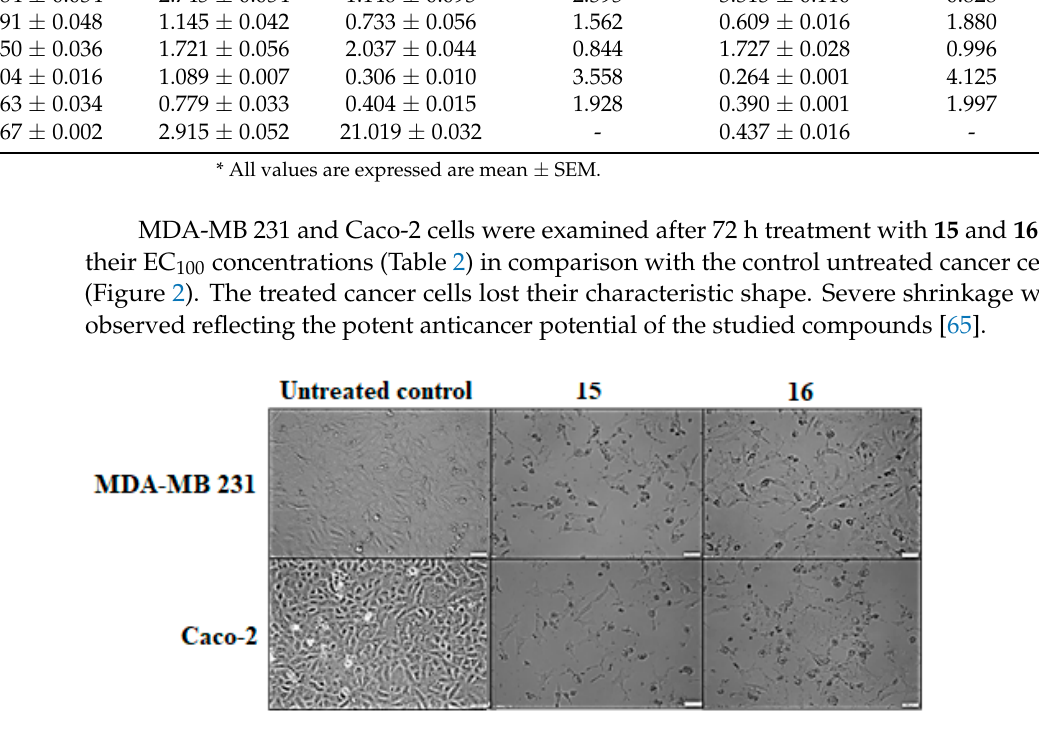
Figure 3. Relative fold change in p53 expression in MDA-MB 231 and Caco-2 cells after treatment with 15 and 16 at their respective IC 50 concentrations. All values are expressed as mean ± SEM.